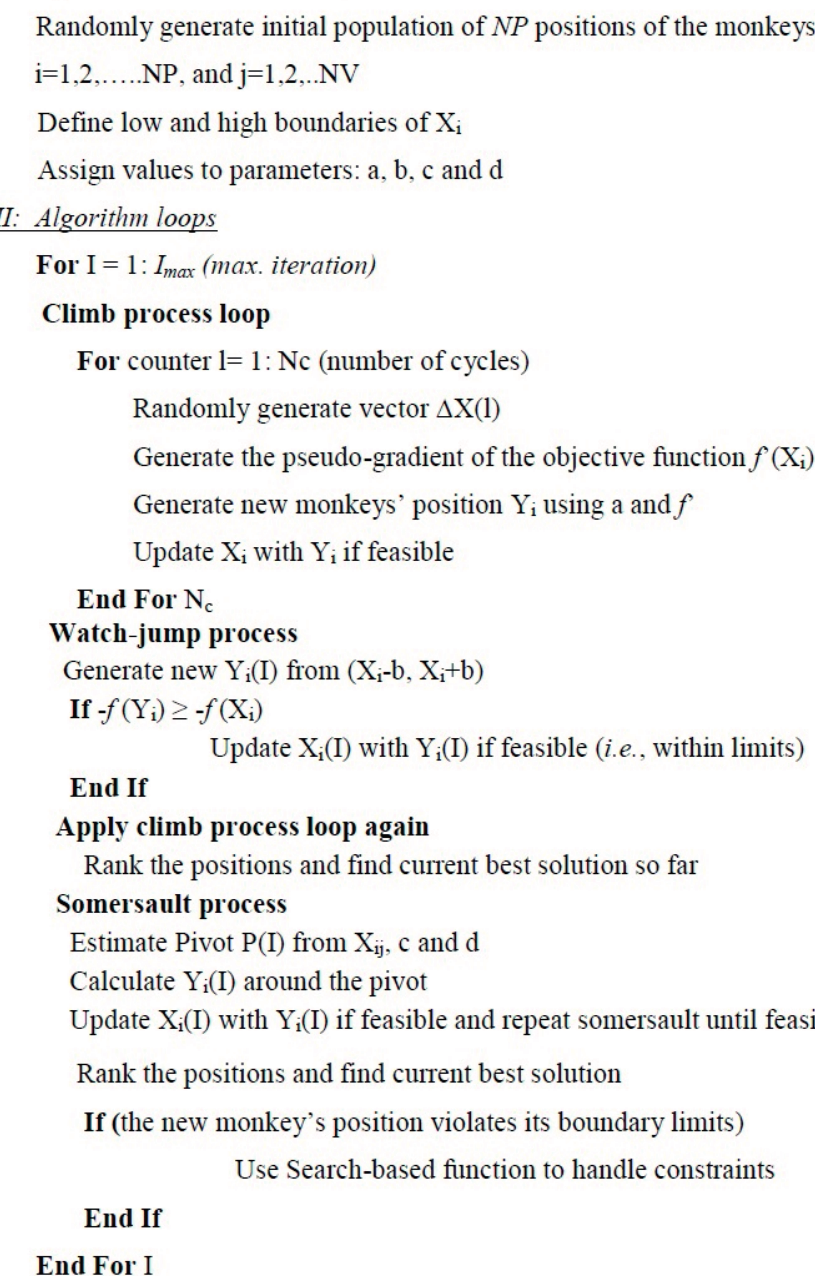
Figure 1. The pseudo-code of the Monkey Algorithm